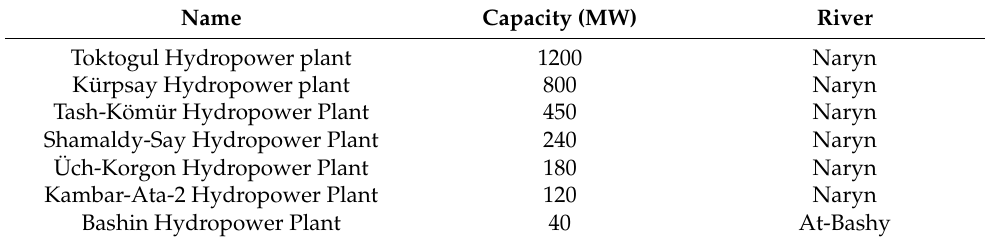
Table 3. Kyrgyzstan’s biggest hydropower plants.